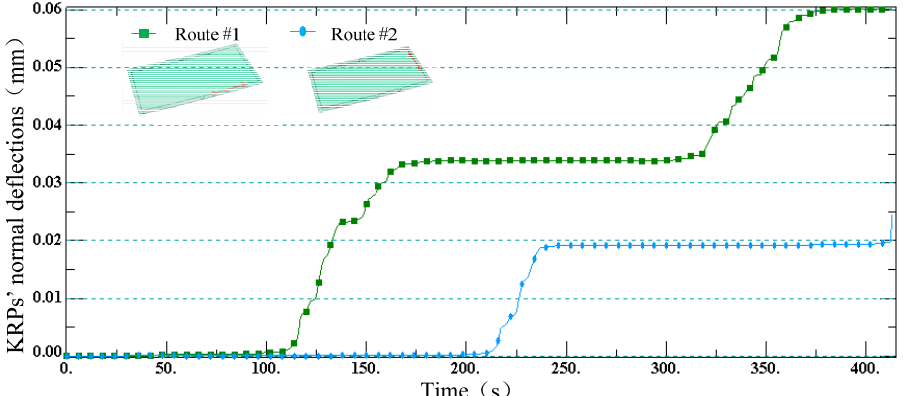
Figure 5. KRPs’ normal deflections of trimming routes with layout #2.